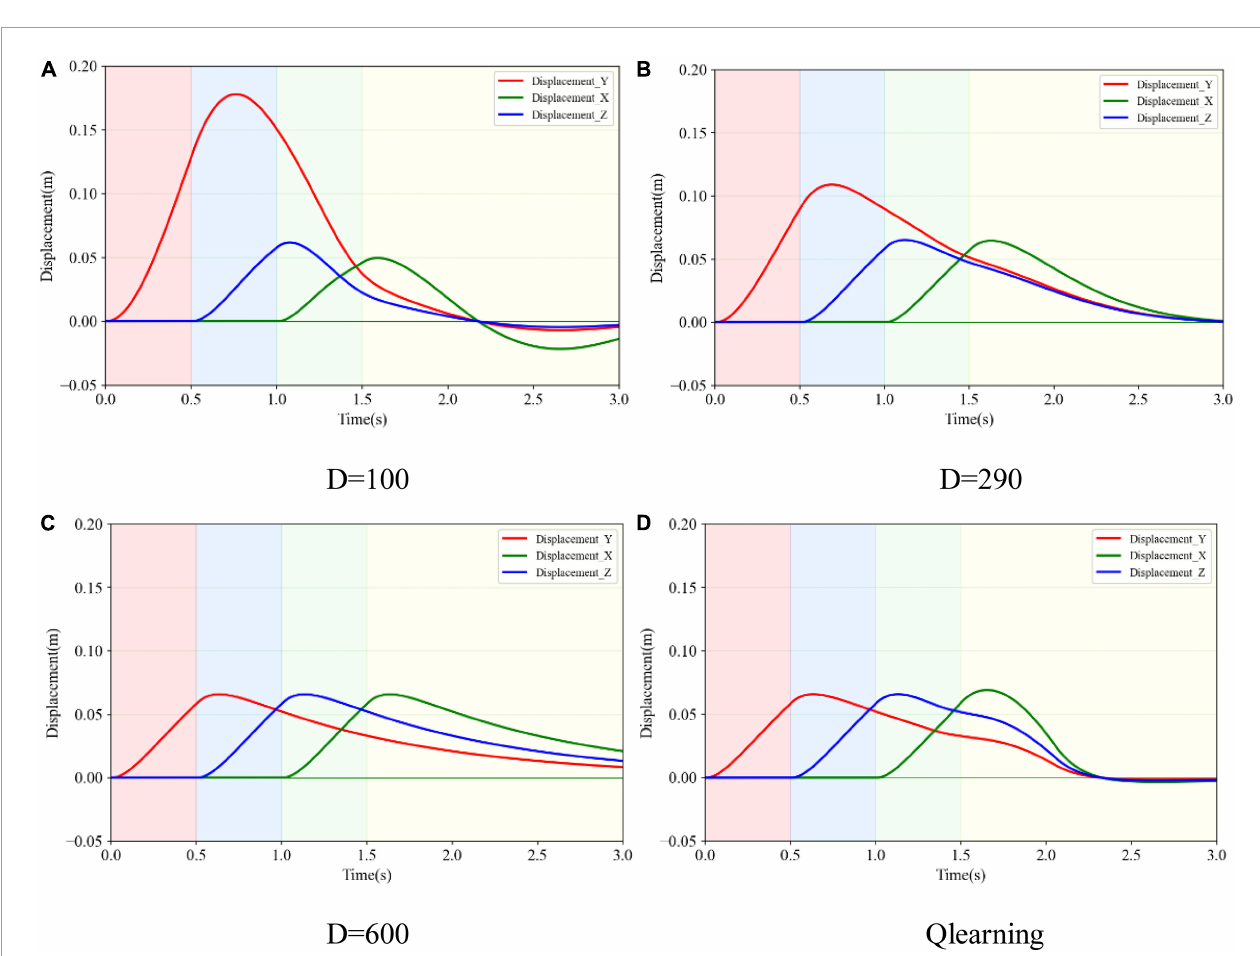
FIGURE8 Three-dimensional displacement variance of the load subjected to three-dimensional impact in different damping cases. (A) Under damping case. (B) Critical damping case. (C) Over damping case. (D) Variable damping case based on Q-learning